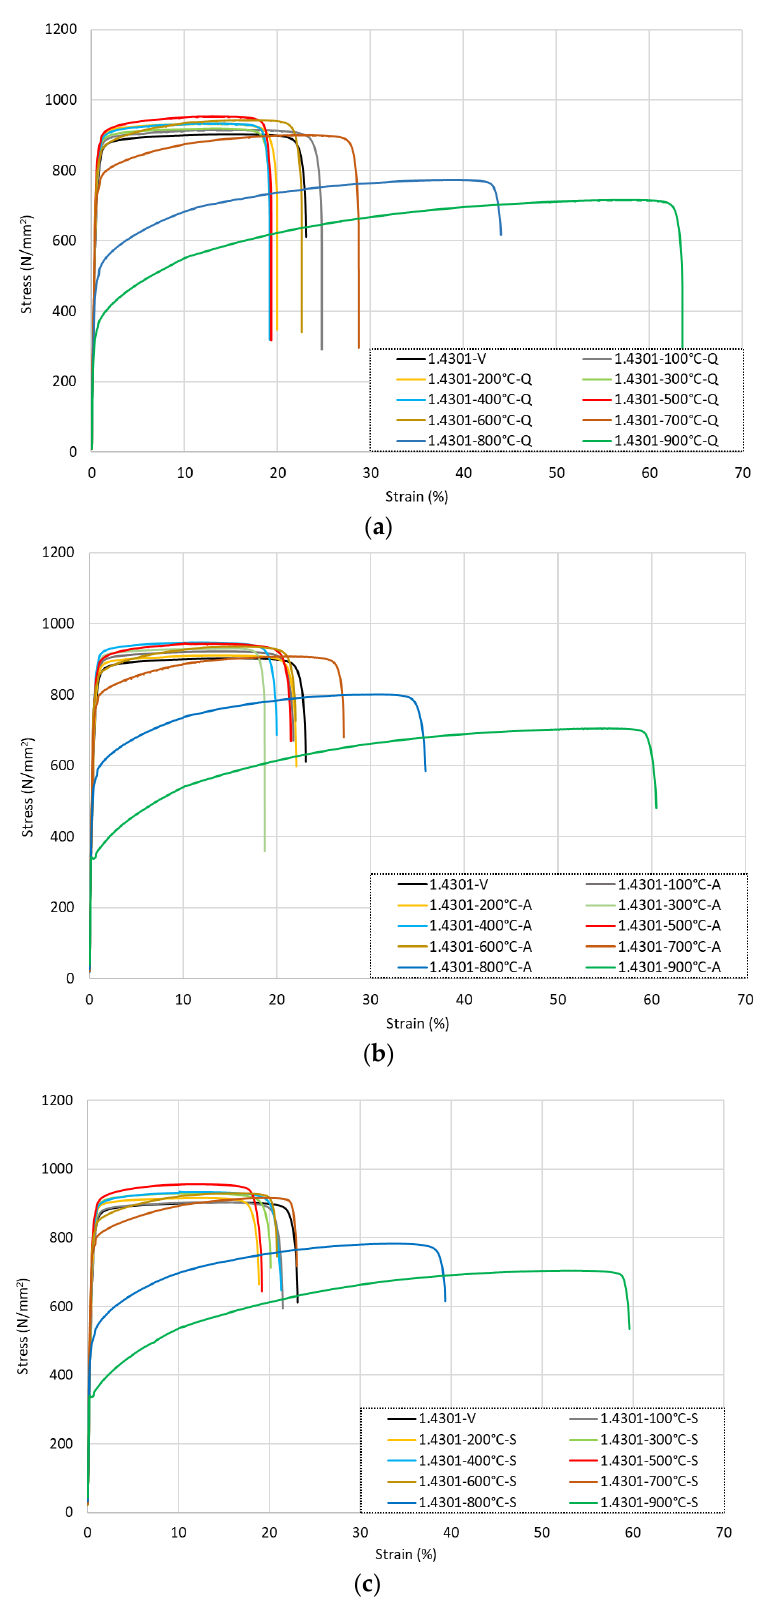
Figure 4. Stress–strain responses for grade 1.4301 stainless steel rebars following exposure to elevated temperatures and then ( a ) quenched in water, ( b ) cooled naturally in air, or ( c ) slow-cooled in the furnace.